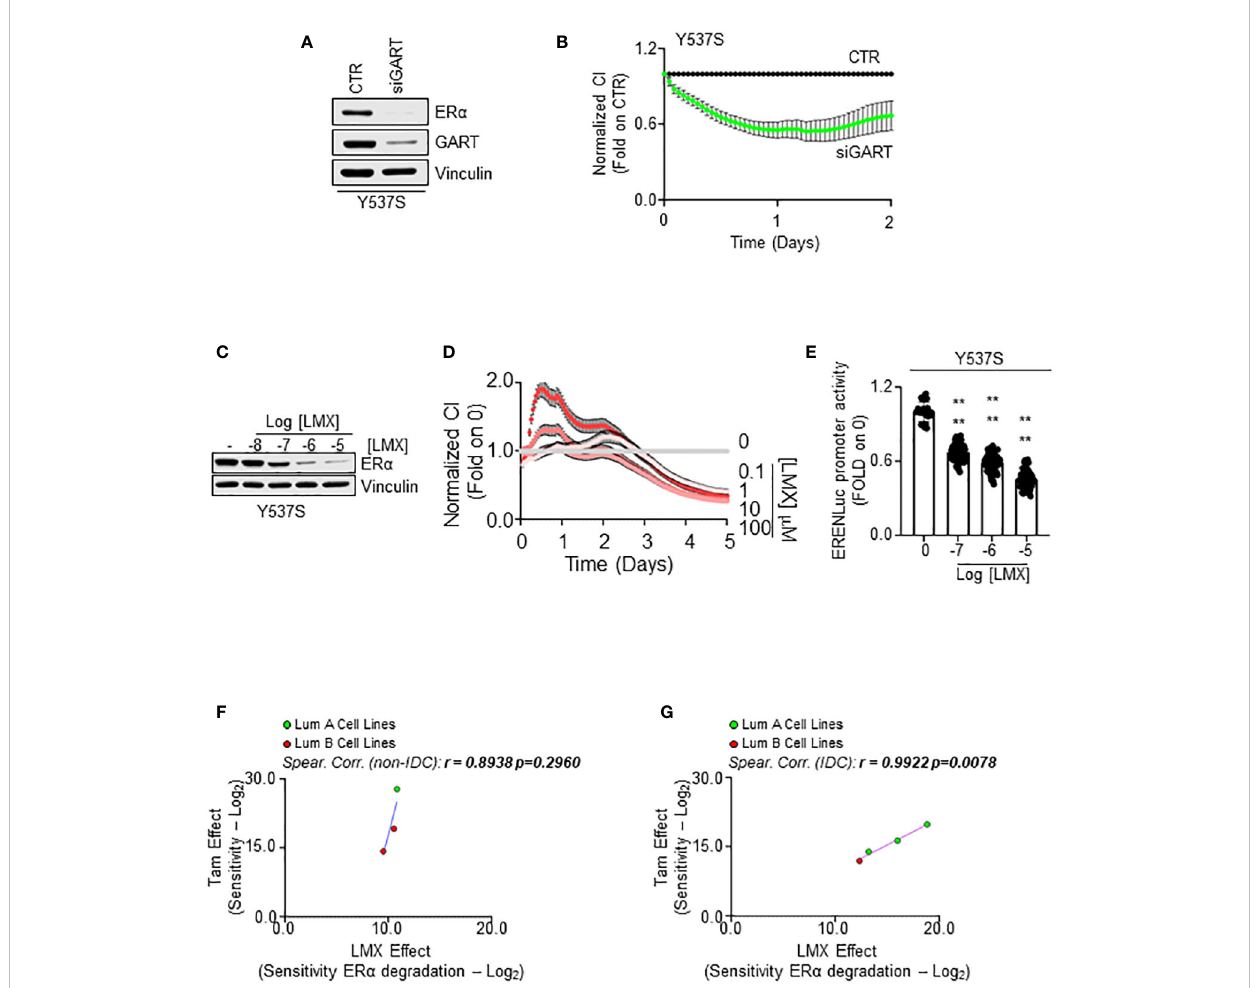
FIGURE 7 The impact of GART inhibition on 4OH-tamoxifen sensitive and resistant cell lines. Western blot analyses of ER a expression levels in Y537S cells treated with GART siRNA oligonucleotides for 24 hours (A) and with the indicated doses (C) of lometrexol (LMX) for 48 hours. Blots are representative images. Densitometric and statistical analyses are reported in Supplementary Figure 4C. Growth curve analyses in Y537S cells were performed as indicated in the material and method section for 3 days in cells treated with GART siRNA oligonucleotides (B) and for 5 days in cells treated with the indicated doses of lometrexol (LMX) (D) . The graphs show the normalized cell index ( i.e. , cell number), which is detected with the xCelligence DP device and calculated at each time point with respect to the control sample. Each sample was measured in quadruplicate. For details, please see the material and methods section. (E) Estrogen response element promoter activity in MCF-Y537S ERE-NLuc cells treated with lometrexol (LMX 1 µM) for 48 hours. The experiments were performed three times in quintuplicate. Signi fi cant differences were calculated with the Anova test. **** ( p-value < 0.0001) indicates signi fi cant differences with respect to untreated ( i.e. , 0) sample. Linear regression and Spearman Correlation values between the sensitivity to 4OH-Tamoxifen (Tam) anti-proliferative activity calculated by performing the -Log 2 transformation of the inhibitor concentration 50 (IC 50 ) for Tam and the sensitivity to lometrexol (LMX)-induced ER a degradation effect as calculated by extrapolating the effective concentration 50 (EC 50 ) and -Log 2 transforming it in different BC cell lines strati fi ed in luminal A (LumA, green dots) and luminal B (LumB, red dots) and non-invasive ductal carcinomas (Not-IDC) (F) or invasive ductal carcinomas (IDC) (G) . r and p-values are given in the main panels. Tam-induced dose-response curves are reported in Supplementary Figure